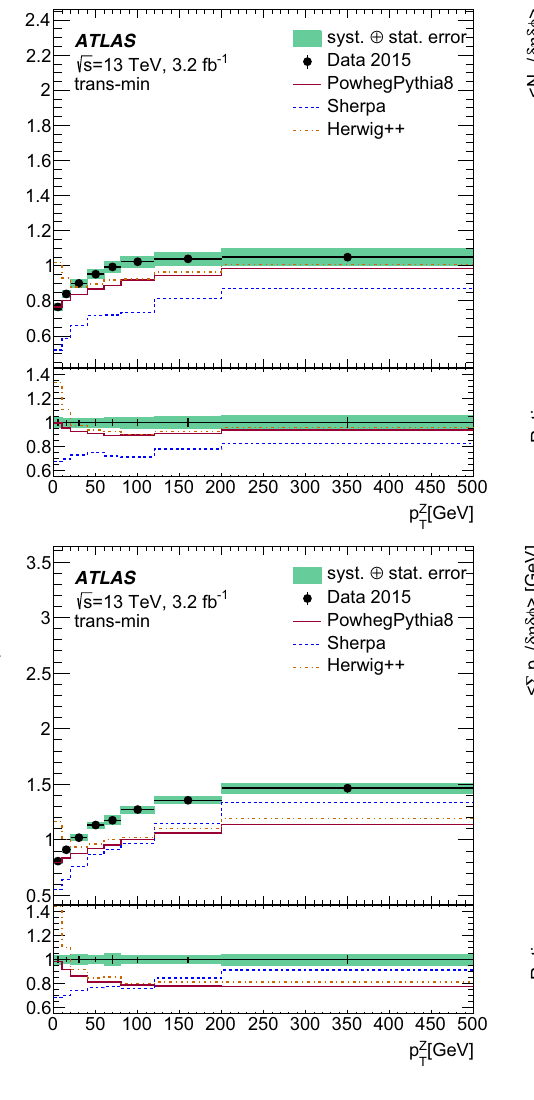
Fig. 9 Comparison of measured arithmetic means of the N ch (upper row) and (cid:8) p T (lower row) as functions of p Z (left) and towards (right) region inclusively in T ⊥ . Predictions of